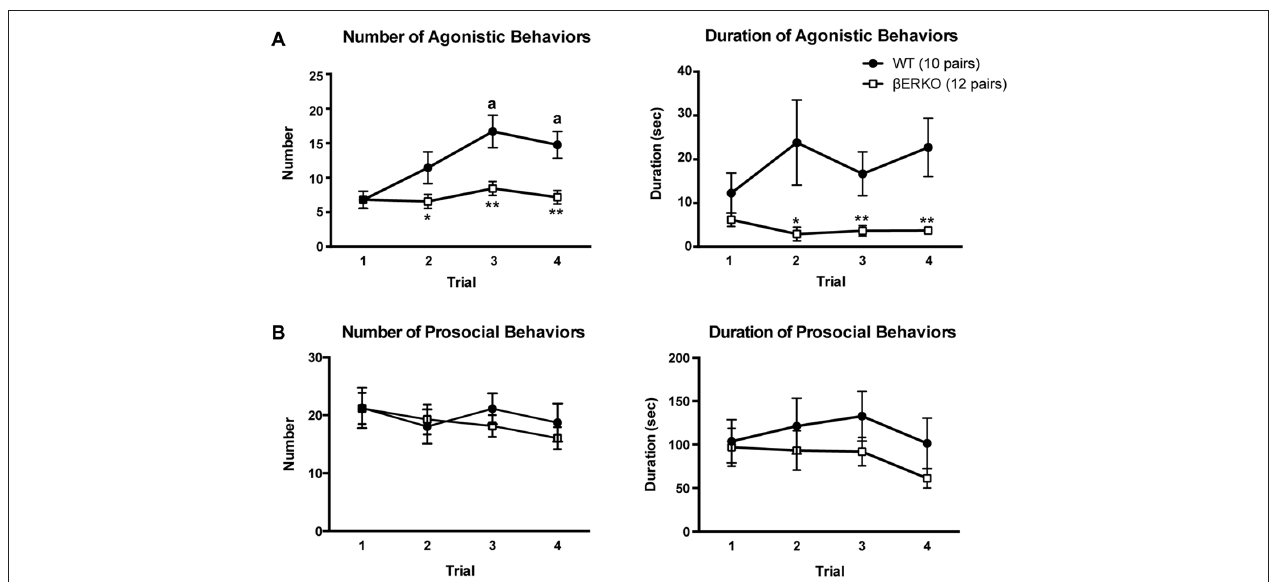
FIGURE 1 | Influence of estrogen receptor β (ER β ) gene disruption on agonistic and prosocial behaviors in the homogeneous set social interaction test. (A) Unlike • wild type (WT; ), ER β knockout ( β ERKO; (cid:3) ) mice did not show an increase in the number (left panel) of agonistic behaviors over trials. Moreover, β ERKO mice showed shorter duration of agonistic behaviors (right panel). (B) There was no difference between β ERKO and WT groups in the number (left panel) and duration (right panel) of prosocial behaviors. All data are presented as mean ± SEM. a p < 0.01 compared with trial 1 of the same genotype; ∗ p < 0.05; ∗∗ p < 0.01 compared with WT in the same trial.